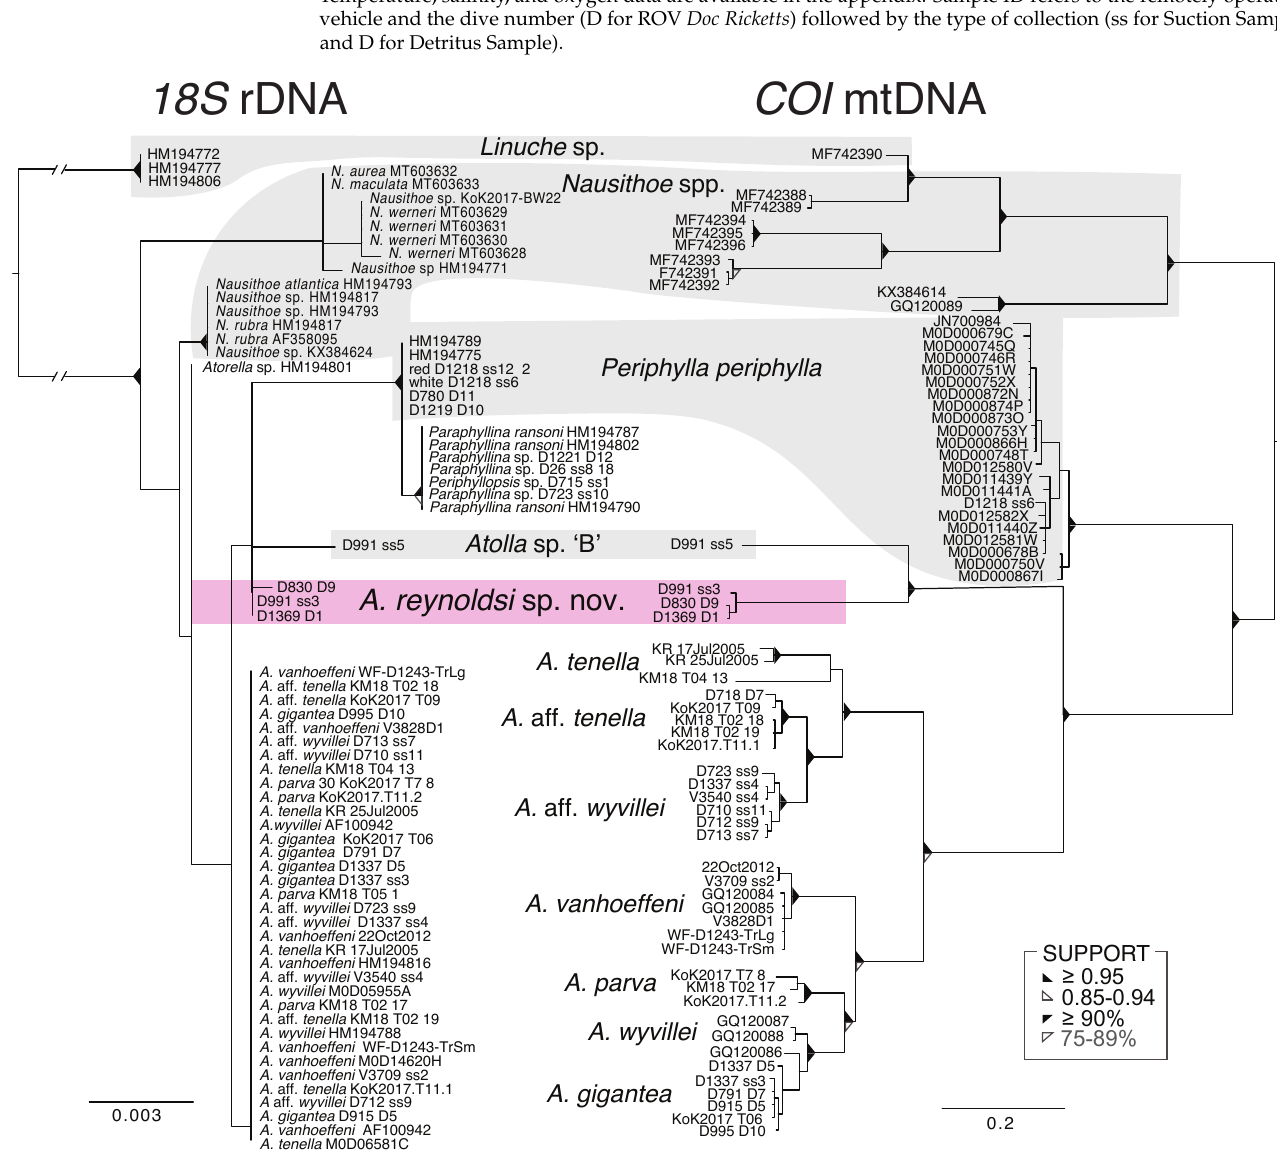
Figure 8. Bayesian and Likelihood estimates of phylogenetic trees for coronate jellies with an 1826 base pairs (bp) alignment of the 18S rDNA fragment with a GTR + I + Γ selection model and an 892 bp alignment of the COI mtDNA fragment with a GTR + I + Γ selection model. Posterior probabilities and bootstrap results displayed as triangles (see legend). Support of nodes with below threshold value not